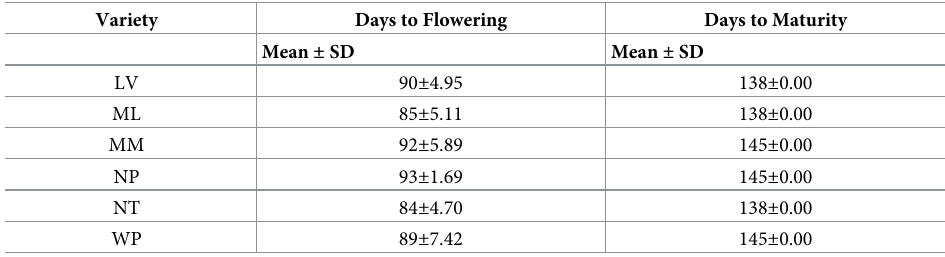
WP 145 ± 0.00 FPV = Frafra Potato Variety; LV = Local variety, ML = Maa-Lana, MM = Manga-Moya, NP = Nutsuga Peisa, NT = Nachim–Tiir, WP = WAAP Peisa; SD = Standard